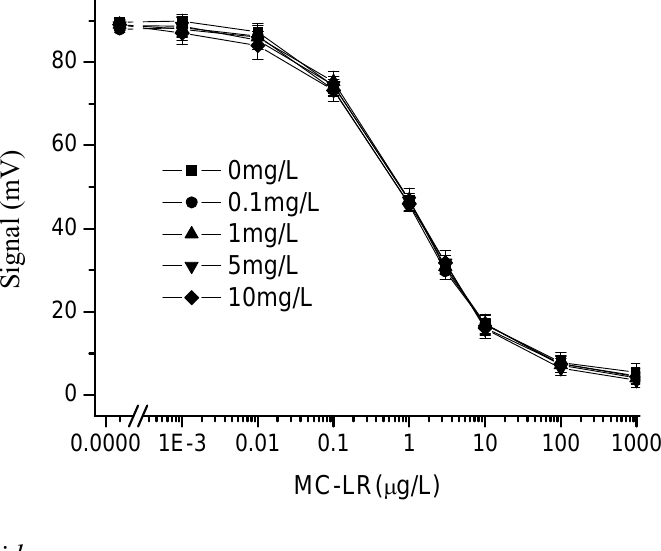
Figure 4. Effect of the copper ions on the MC-LR immunoassay based on EWAI (6 μ L 1mg/mL EDTA added to the mixture). The concentration of CuSO mg/L.